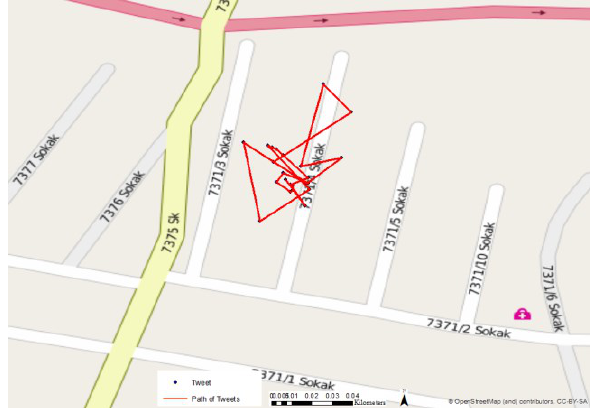
Figure 13. Over Tweets